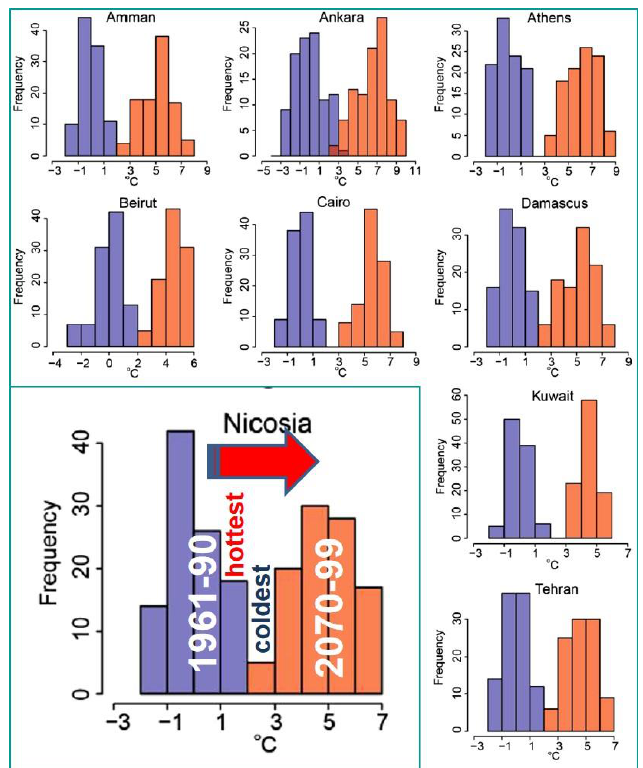
Figure 6. Recent and end-of-century temperature anomalies for a number of MENA and eastern Mediterranean country capitals. Model calculated frequency histograms (%) of daytime maximum summer (JJA = June, July, August) temperature deviations from the three-months-mean, relative to the period 1961–1990, based on the A1B scenario. Blue is for the period 1961–1990 (hence centered around 0 °C) and red for the period 2070–2099; the large insert illustrates the major characteristics of the observed warming trend for Nicosia; adapted and modified from [29,38] .